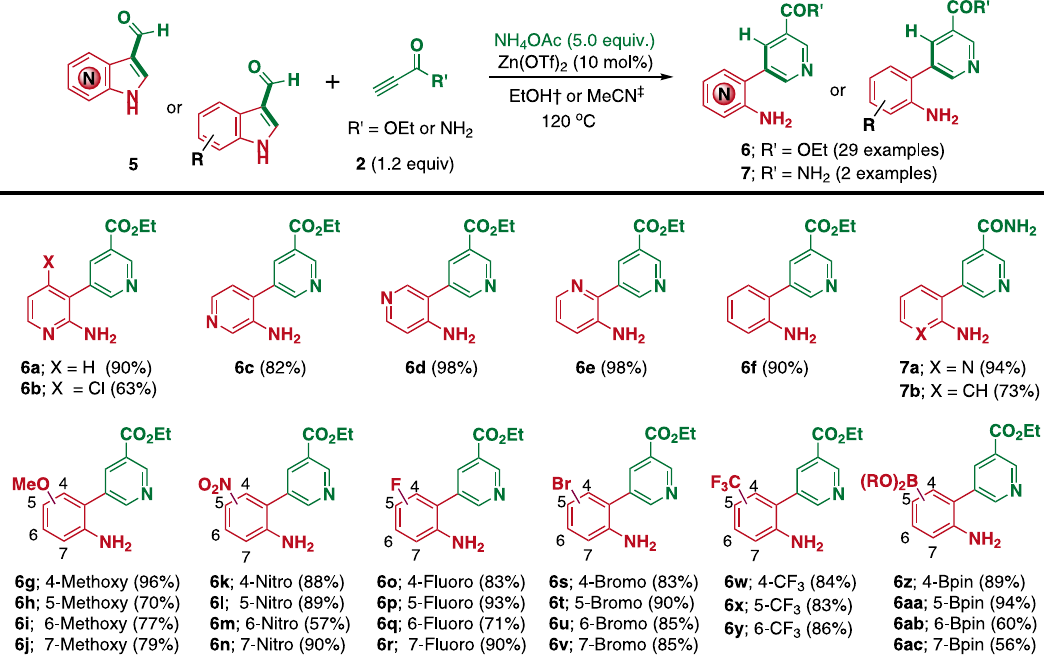
Fig. 3 Substrate scopes for synthesis of nicotinated anilines/aminopyridines via (aza)indoles skeleton remodeling. Reaction conditions: 5 (0.2 mmol), 2 (1.2 equiv.), NH 4 OAc (5.0 equiv.), and Zn(OTf) 2 (10 mol%) at 120 °C. † Reactions were performed in EtOH (2.0 mL) for 6 h in the case of azaindole- based substrates ( 6a ‒ 6e , 7a ). ‡ Reactions were performed in CH 3 CN (2.0 mL) for 16 h in the case of indole-based substrates ( 6 f ‒ 6ac , 7b ). Yields of the isolated products ( 6 and 7 ) are